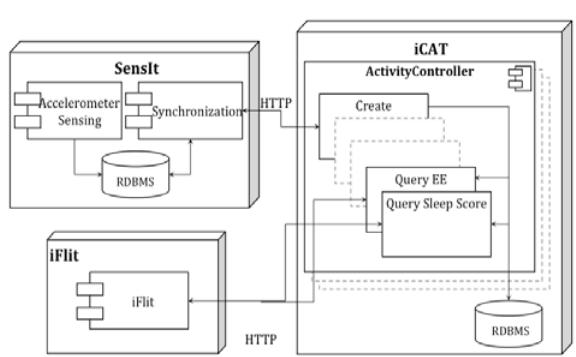
Figure 3. Architecture of iFlit